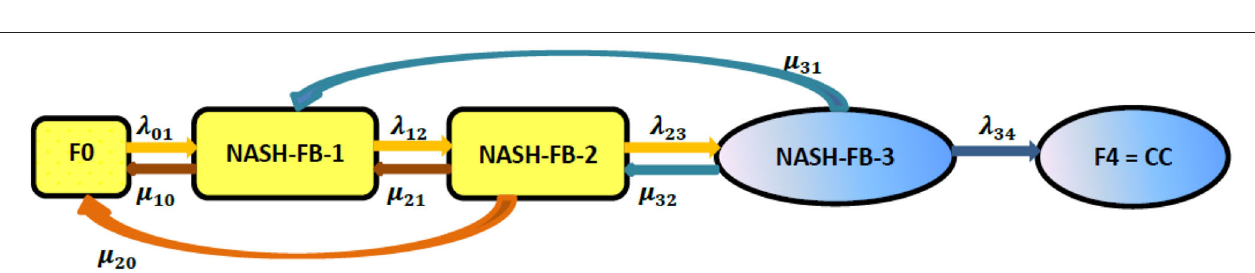
FIGURE 3 | NAFLD with the evolving fibrosis stages [4]. F0, no fibrosis (stage 0); NASH-FB-1, non-alcoholic steatohepatitis with mild fibrosis (stage 1); NASH -FB-2, NASH with moderate fibrosis (stage 2); NASH -FB-3, NASH with advanced or severe fibrosis (stage 3); CC, compensated cirrhosis (stage 4) which is the more severe or advanced form of